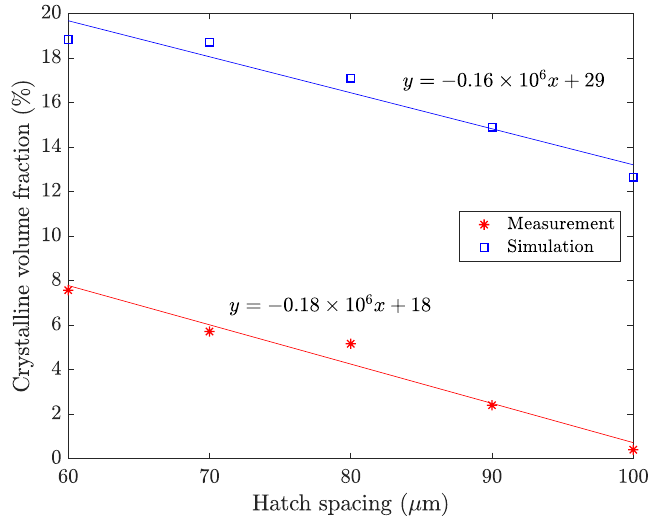
Figure 6. Simulated and experimentally estimated crystalline volume fraction with respect to hatch spacing. Laser power and hatch length are constant at 80 W and 5 mm, respectively. The R 2 value for the fitted lines are 0.97 and 0.93 for the measurement and simulation,